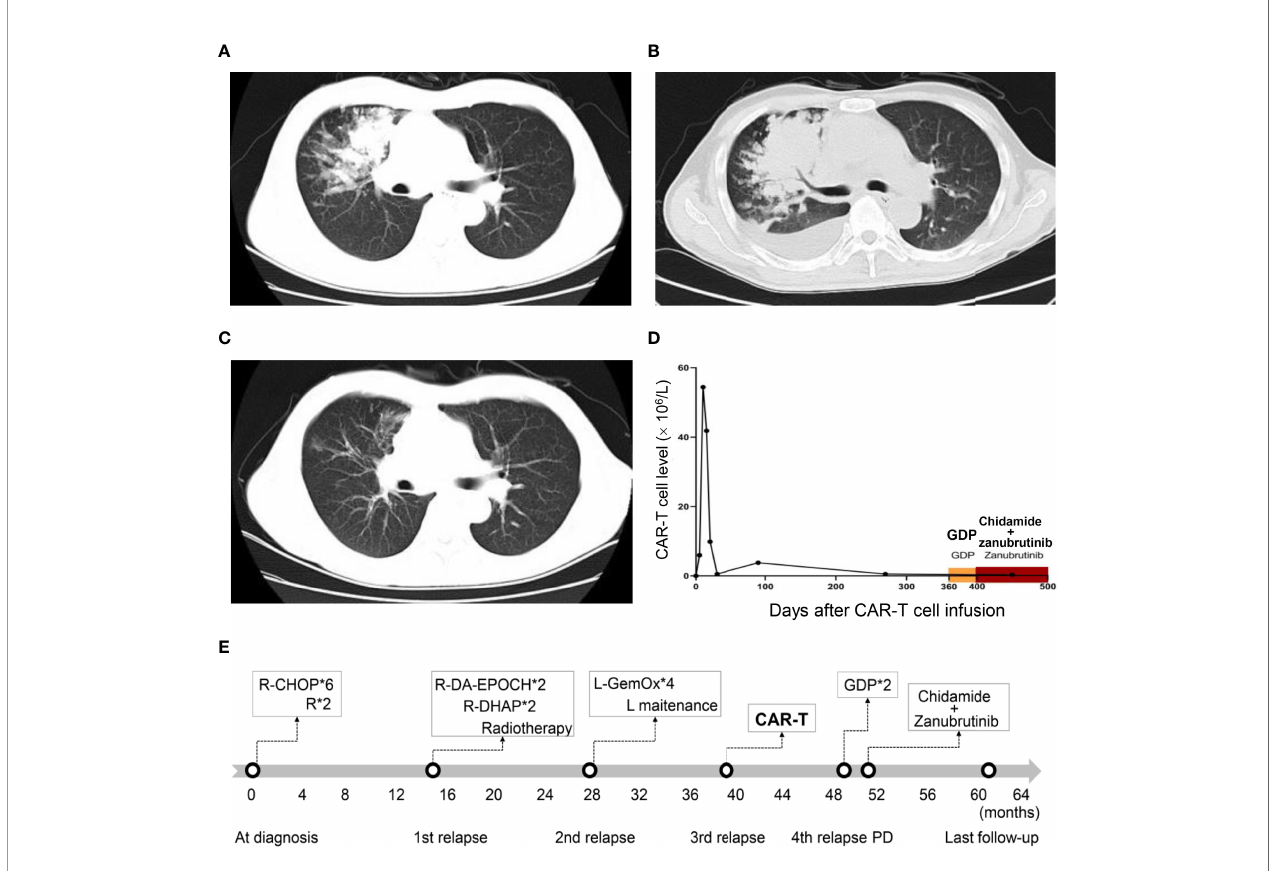
FIGURE 2 | Computed tomography and CAR-T cell monitoring after CAR-T infusion. (A) Axial CT image at relapse after CAR-T therapy. (B) Axial CT image before the combination treatment of chidamide and zanubrutinib, showing disease progression. (C) Axial CT image 2 months after the combination treatment of chidamide and zanubrutinib, showing disease remission. (D) CAR-T cell monitoring after CAR-T cell infusion. (E) Timeline of diagnosis and treatment. “ * ” means “ times ” (or